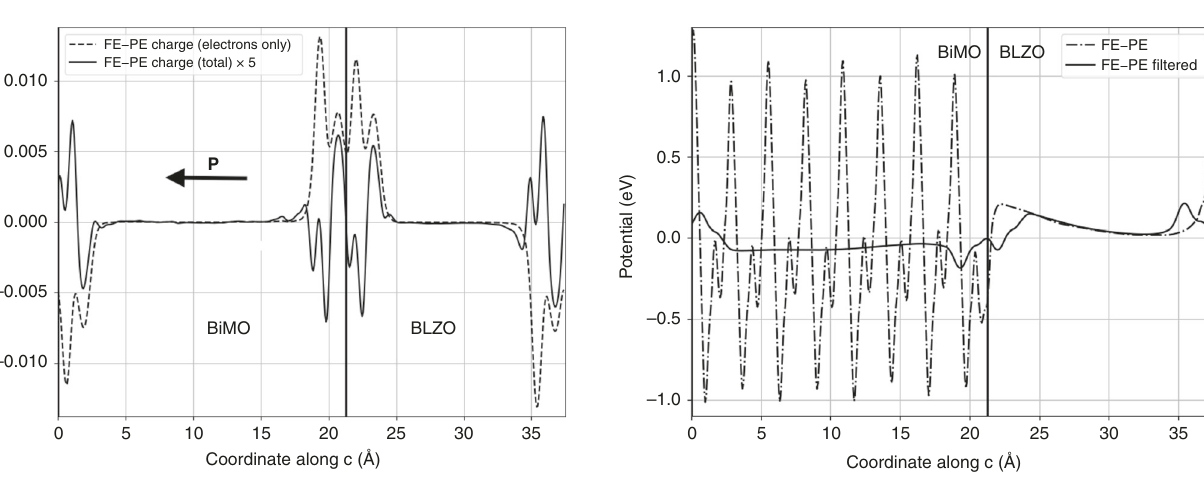
Fig. 5 Interface charges in BiMO/insulator superlattice. Filtered averages of electronic charge and of total charge in the BiMO – BLZO SL, showing polarization-originating charge accumulation at the interfaces. Solid line and y axis mark the geometric interfaces. Negative charge drawn as positive.